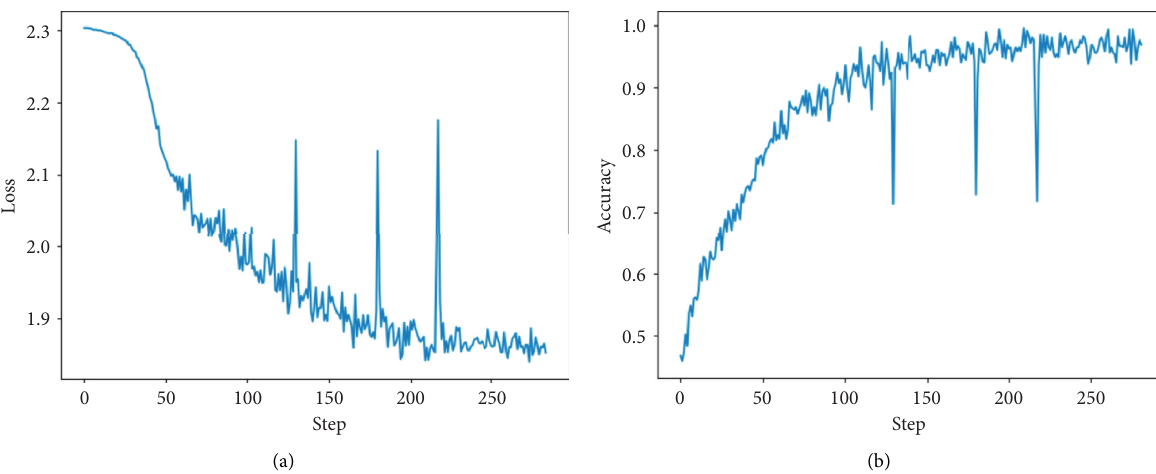
Figure 8: The quantitative experimental results. (a) The agent’s classification loss. (b) The agent’s classification